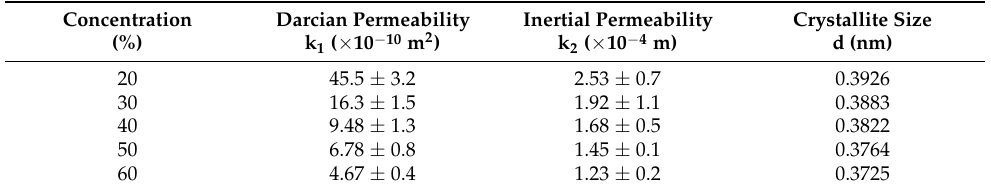
Table 1. Permeability constants and crystallite size of C WCMs sample with different resin concentra- tion under a constant filling rate of 37.5%.